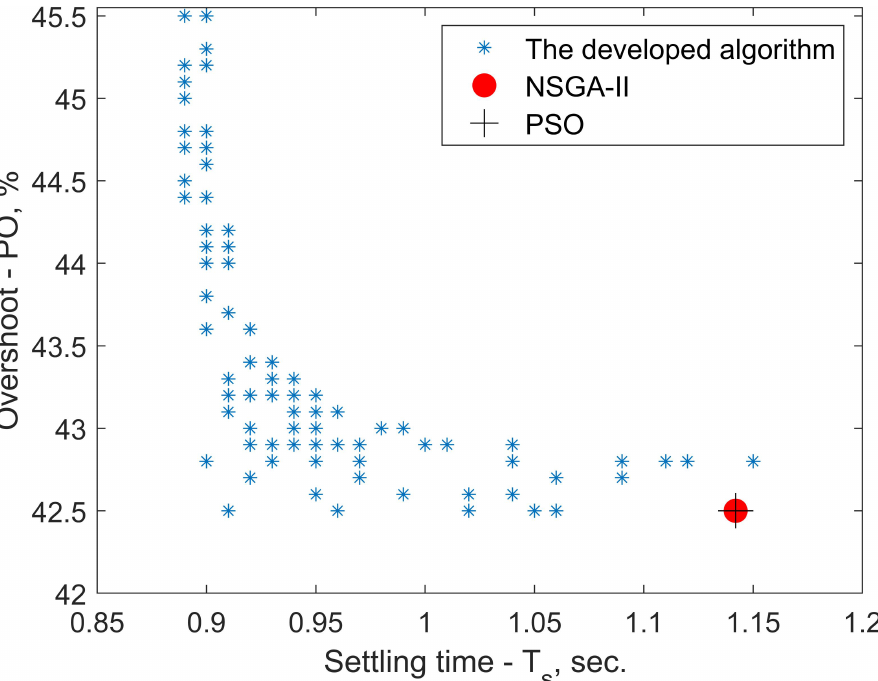
Figure 13. A comparison between the developed algorithm and genetic search methods. With the used boundaries for the decision variables ( K p , K i , K d ) the developed algorithm proved to be insensible to the local minima trapping effect as it showed multiple solutions on the Pareto set. Combined with fast computations, this makes for an optimal choice for a design method involving transient response